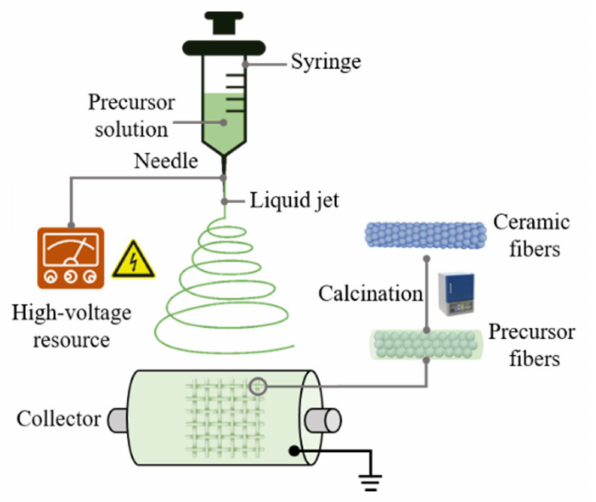
Figure 2. Schematic for the preparation of ceramic fibers by